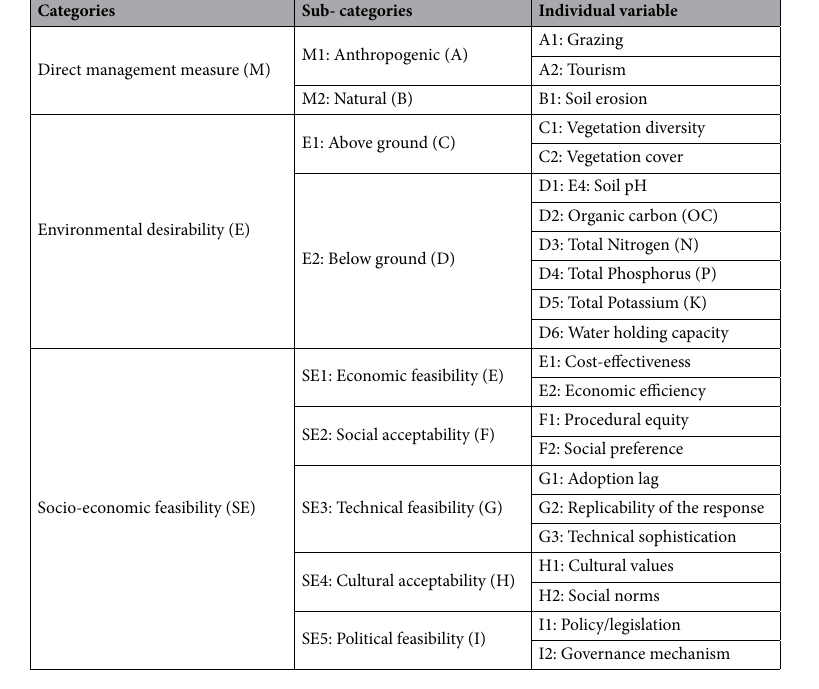
Table 6. Response evaluation parameters.